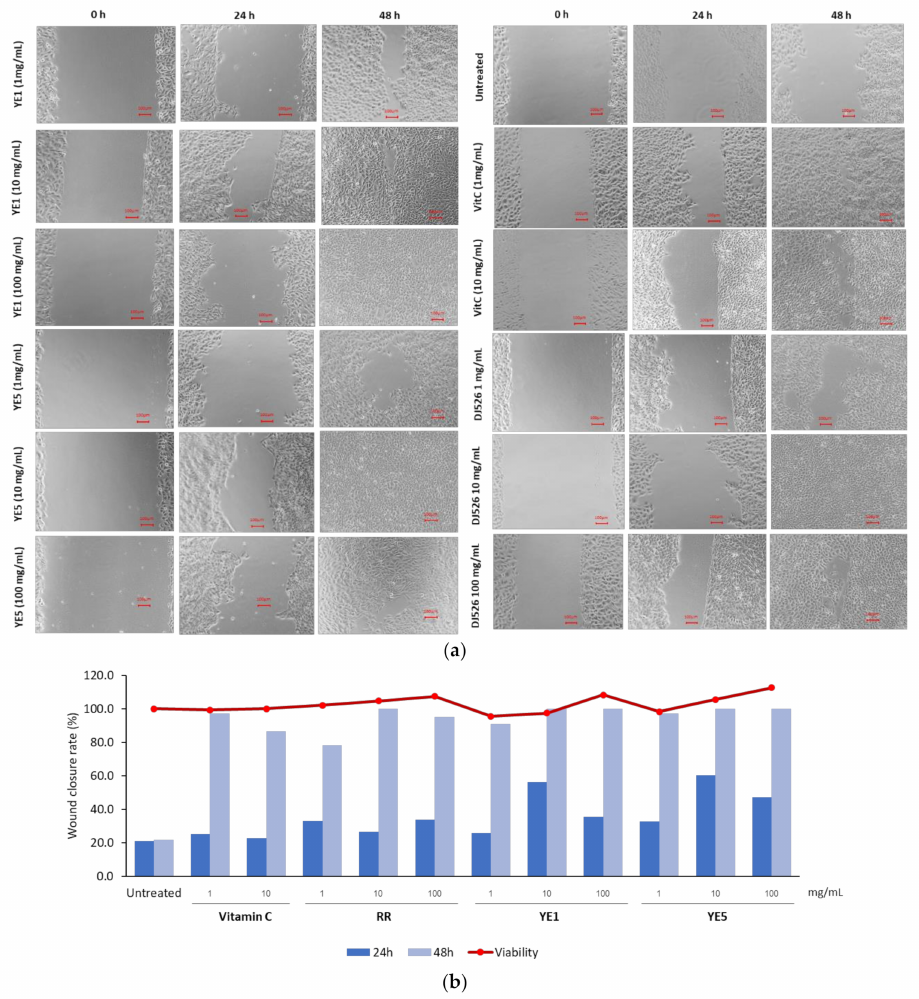
Figure 4. Wound-healing activity of DJ526, YE1, and YE5 treatment. ( a ) Microscopic images of wound gap closure at 0, 24, and 48 h (10 × magnification). Scale bars indicate 100 µ m. ( b ) Wound closure rate of DJ526, YE1, and YE5 treatments at concentrations of 1, 10, and 100 mg/mL compared with vitamin C (positive